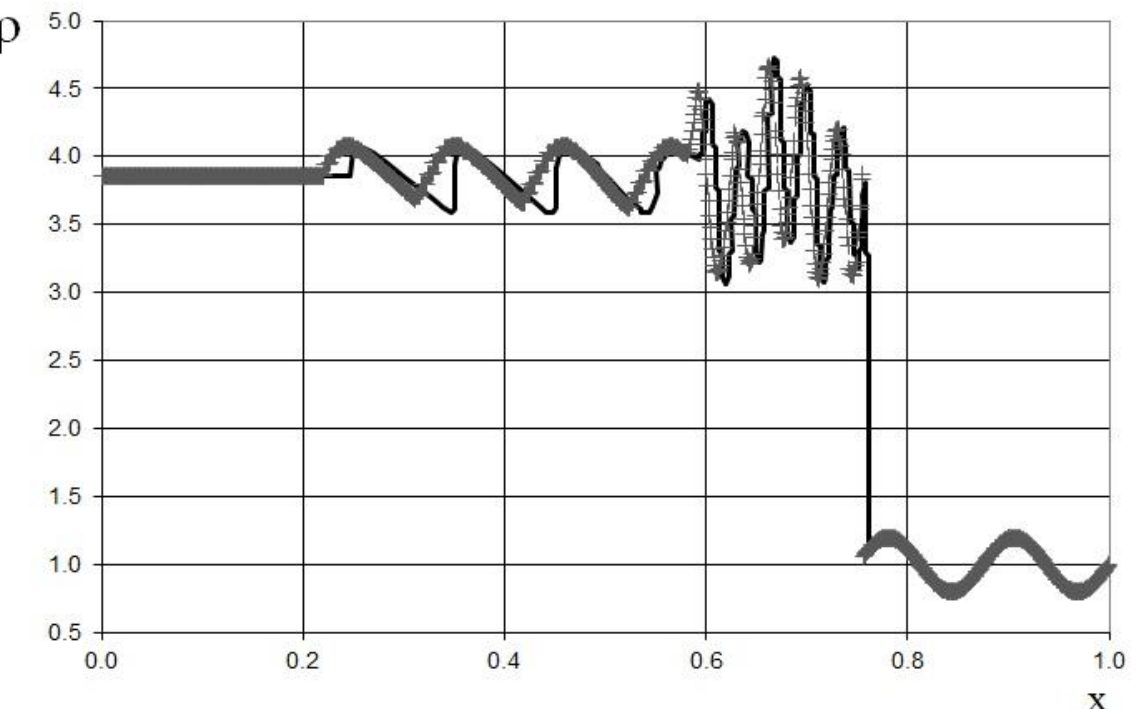
Figure 24. Density plot for the Shu–Osher shock-tube problem, using the fine grid (384 grid points): the “exact” solution [44] (line), and the present method (cross).